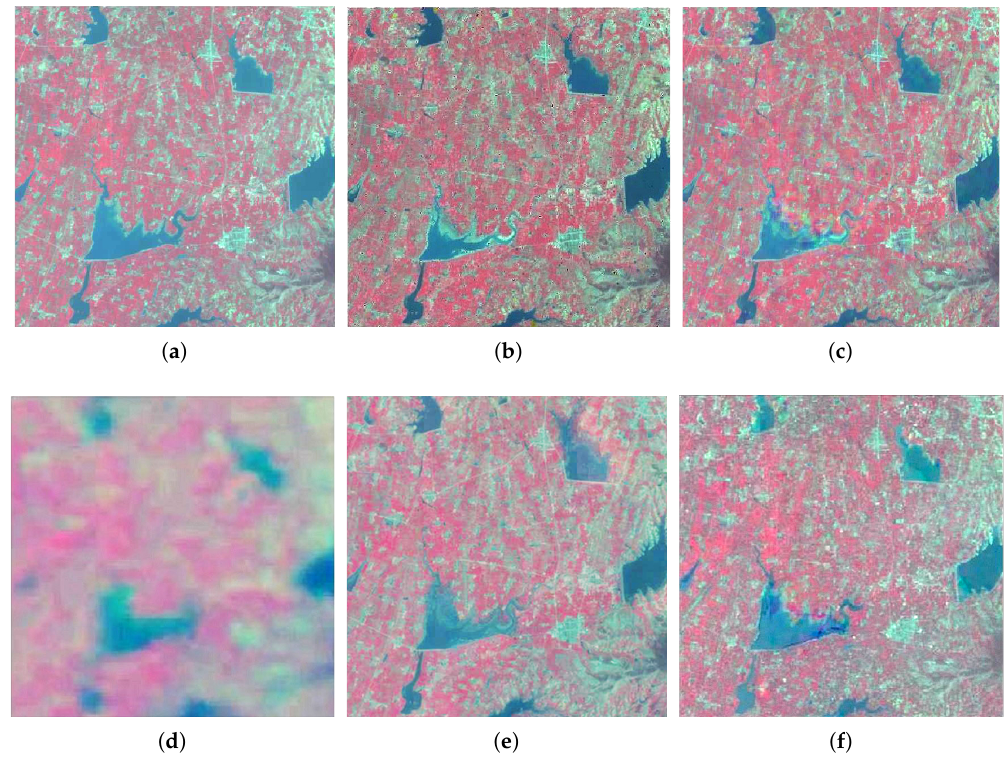
Figure 9. Reconstruction results of type changes images: ( a ) the actual Landsat image; ( b ) predicted result of STARFM; ( c ) predicted result of SPSTFM; ( d ) predicted result of SRCNN; ( e ) predicted result of STARF; ( f ) predicted result of